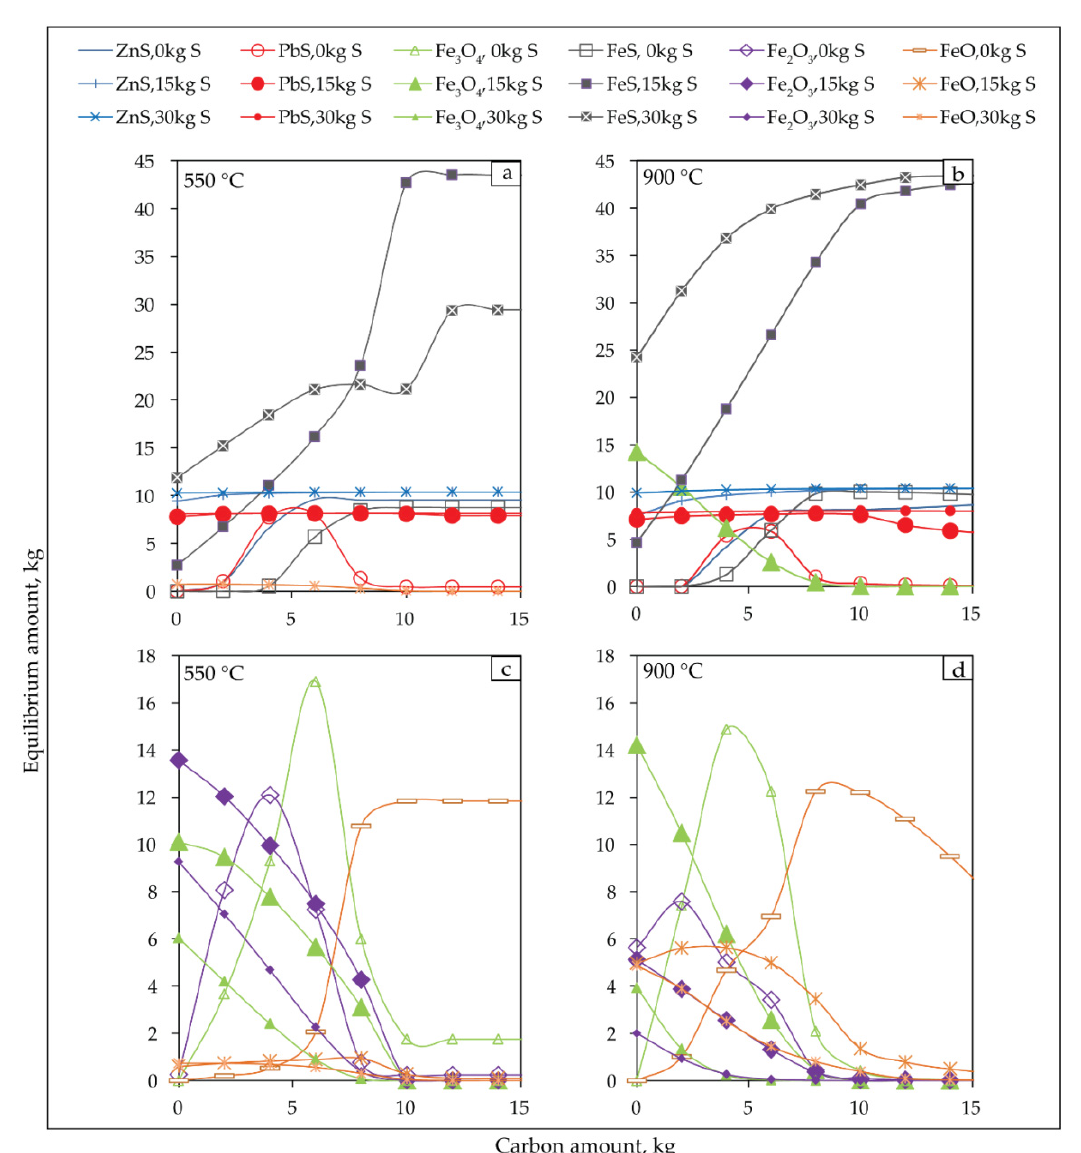
Figure 12. Equilibrium amounts of the sulphide ( a , b ) and oxide products ( c , d ) of sulfidization jarosite-PbAg sludge as functions of carbon and sulfur dosage, and temperature 550 °C ( a , c ) and 900 °C ( b , d ).